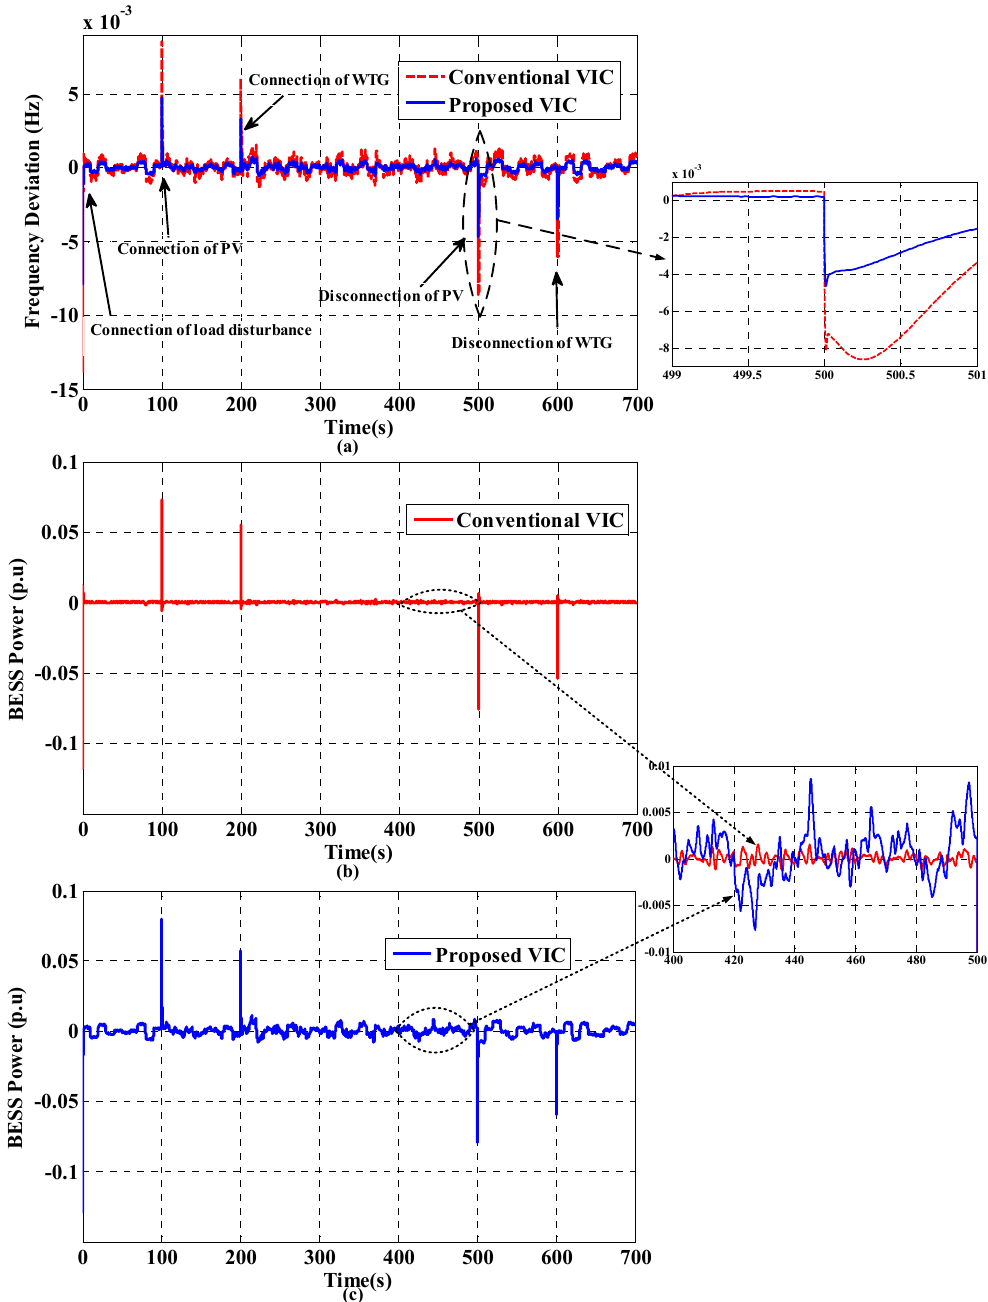
Figure 14. MG dynamic responses for scenario in Section 5.2.2.1. ( a ) Resulted frequency responses. ( b ) Power of conventional VIC-based BESS. ( c ) Power of proposed VIC-based BESS.